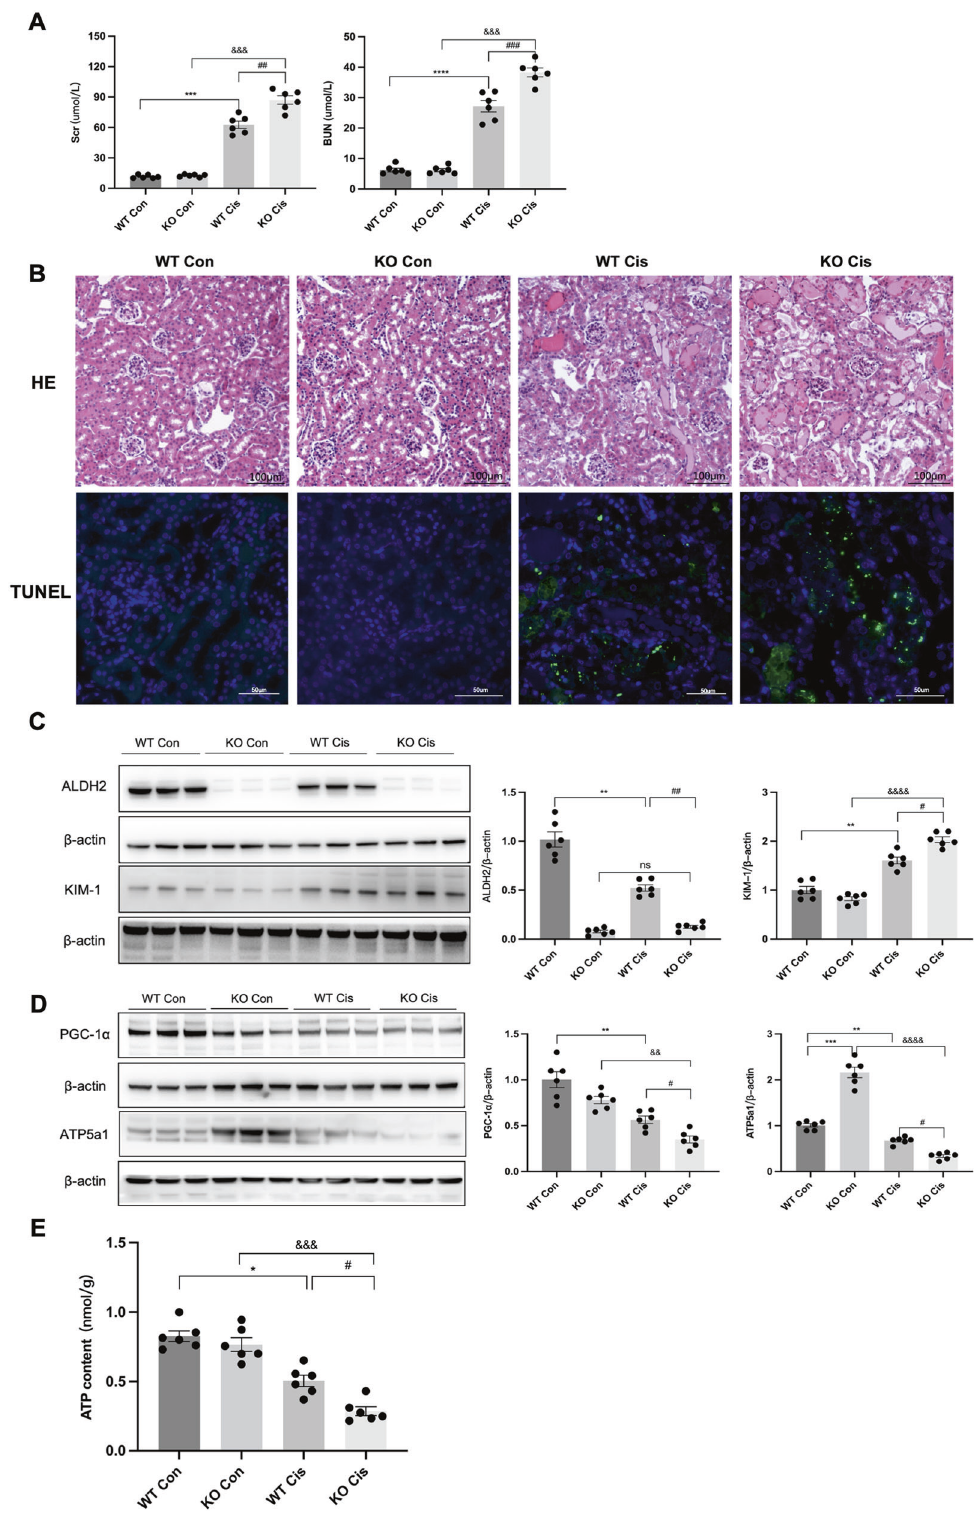
Fig. 2 ALDH2 knockout aggravated renal injury in cisplatin-induced AKI. A Serum creatinine (Scr) and urea nitrogen (BUN) levels were measured in each group ( n = 6). B Images of hematoxylin-eosin (HE) staining ( n = 6). Scale bars, 100 μ m; Terminal deoxynucleotidyl transferase – mediated dUTP nick end-labelling (TUNEL) assay were used to evaluate the tubular apoptosis ( n = 6). Scale bars, 50 μ m. C The expression of ALDH2 and KIM-1 was measured by western blotting ( n = 6). D The expression of mitochondria-related proteins (PGC-1 α and ATP5a1) was measured by western blotting ( n = 6). E ATP levels were assessed using an ATPAssay Kit (n = 6). * P < 0.05, ** P < 0.01, *** P < 0.001, **** P < 0.0001; # P < 0.05, ## P < 0.01, ### P < 0.001, #### P < 0.0001; & P < 0.05, && P < 0.01, &&& P < 0.001, &&&& P < 0.0001; ns not signi fi cant. (WT